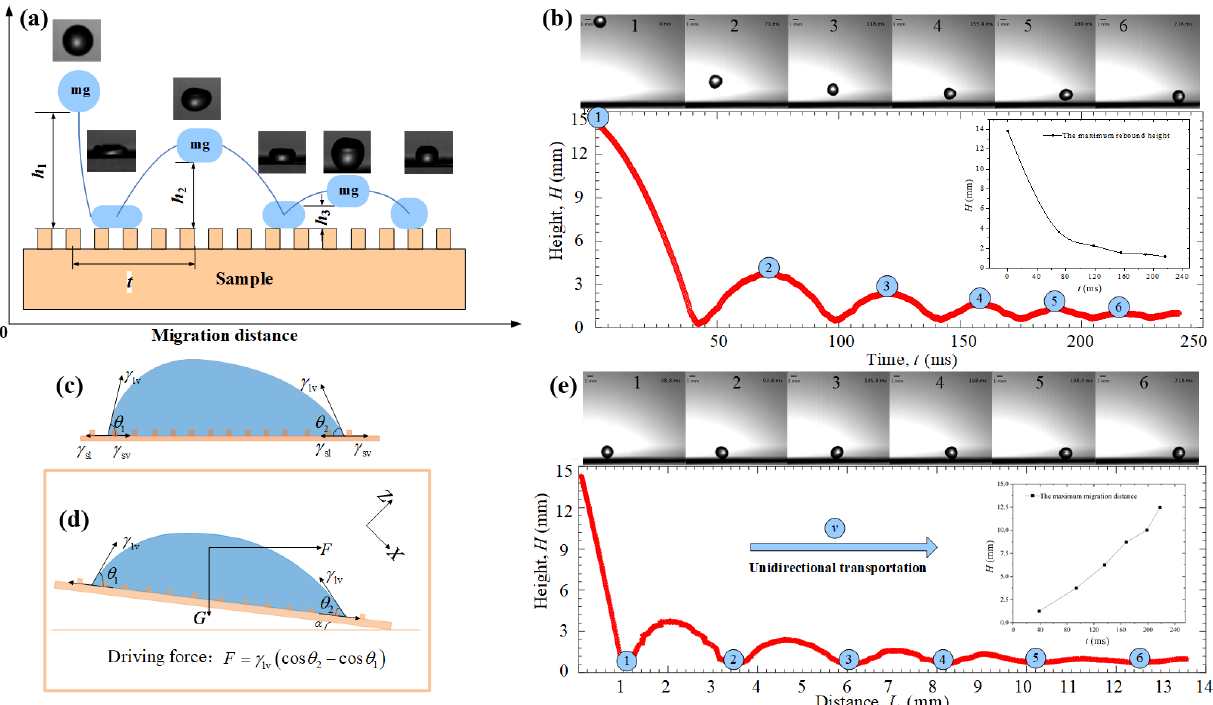
Fig. 4 Theoretical model and experimental data diagram showing bounce and transport of liquid droplets on surface of dragonfly wing bladder in presence of force. (a) Tentative description of rebound height and migration throughout impact process, and "mg" represents the gravity of the drop. (b) Complete rebound phenomenon of drop on dragonfly wing surface in vertical direction (maximum rebound height). Analysis of drop forces in different planes: (c) Analysis of plane drop force; (d) X -axis gravity analysis on inclined surface; (e) transport of drop impacting dragonfly wing surface in horizontal direction (maximum migration